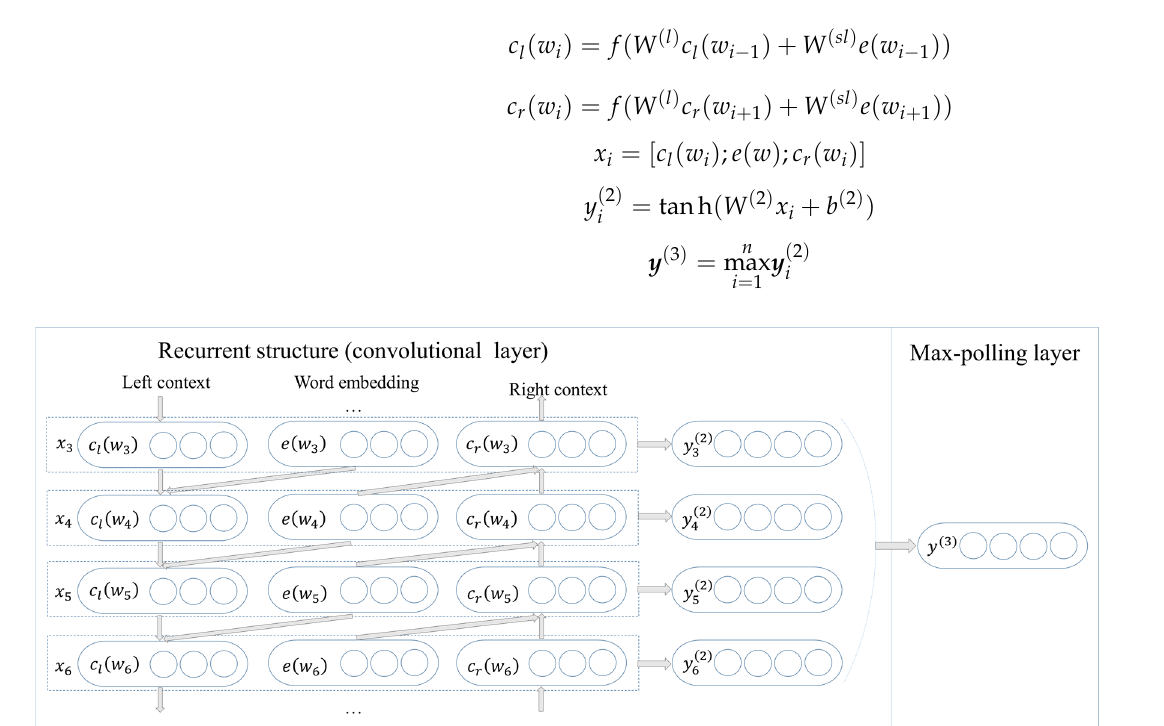
Figure 2. The main structure of RCNN.